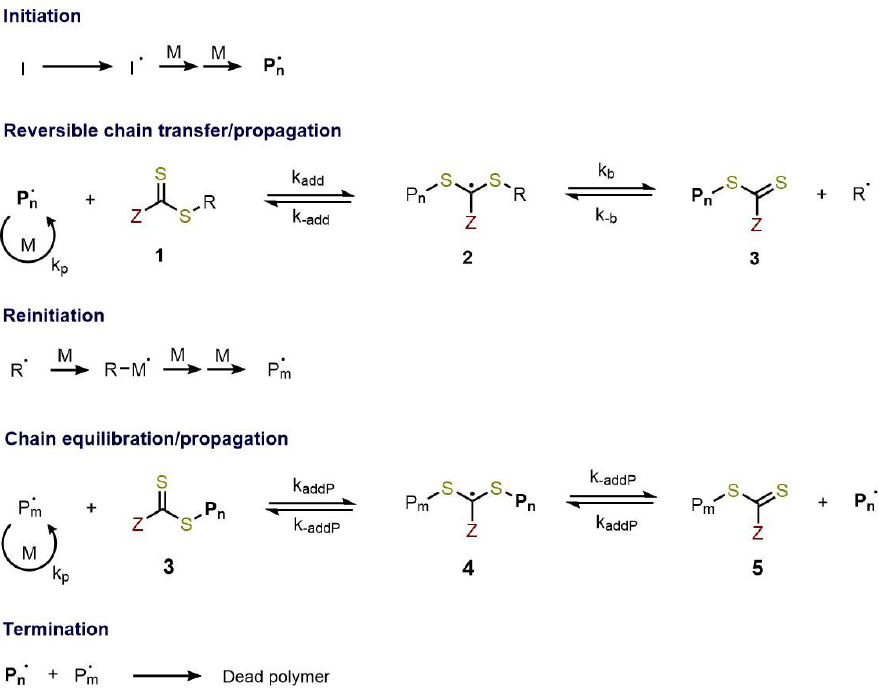
Figure 2. Mechanism of RAFT polymerization